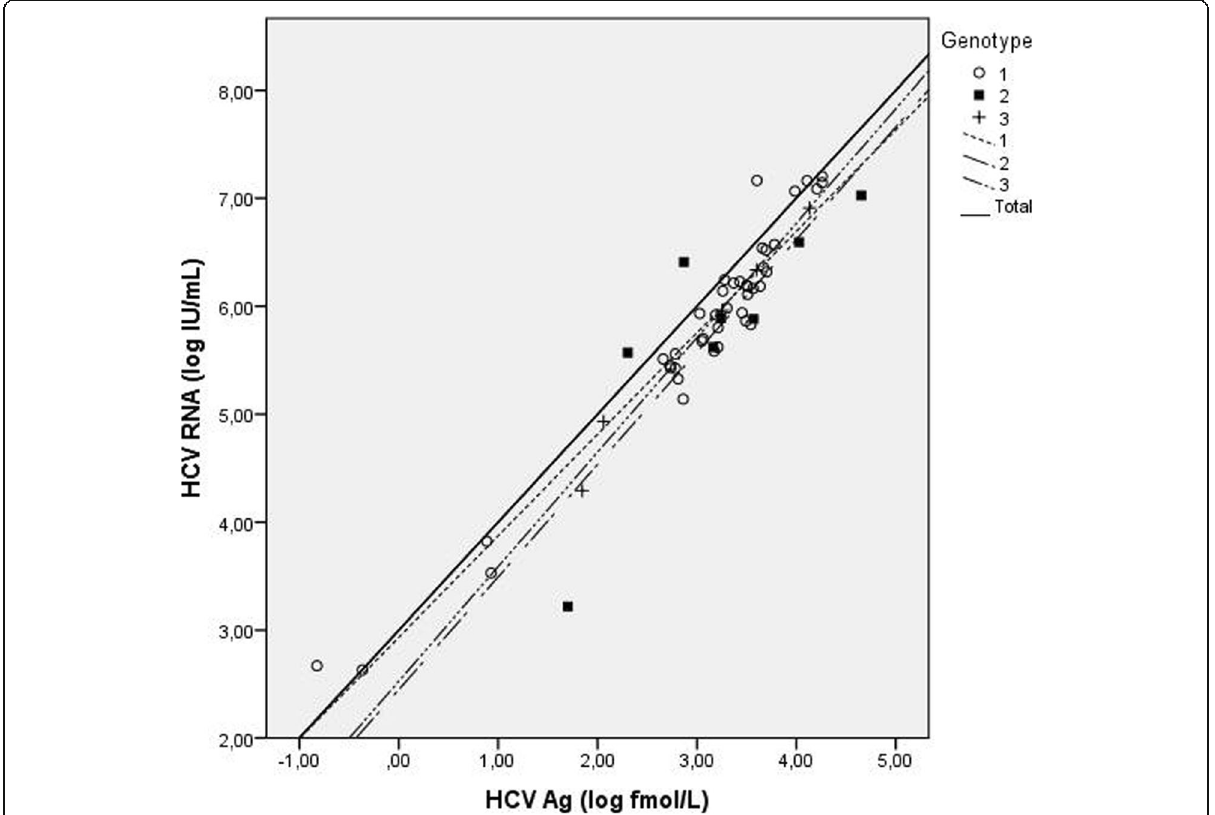
Fig. 2 Correlation diagram of HCV Ag (log10 fmol/L) and HCV RNA (log10 IU/mL) according to genotype for 59 genotyped